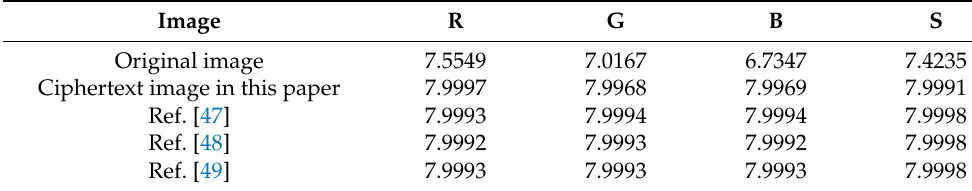
Table 6. Image information